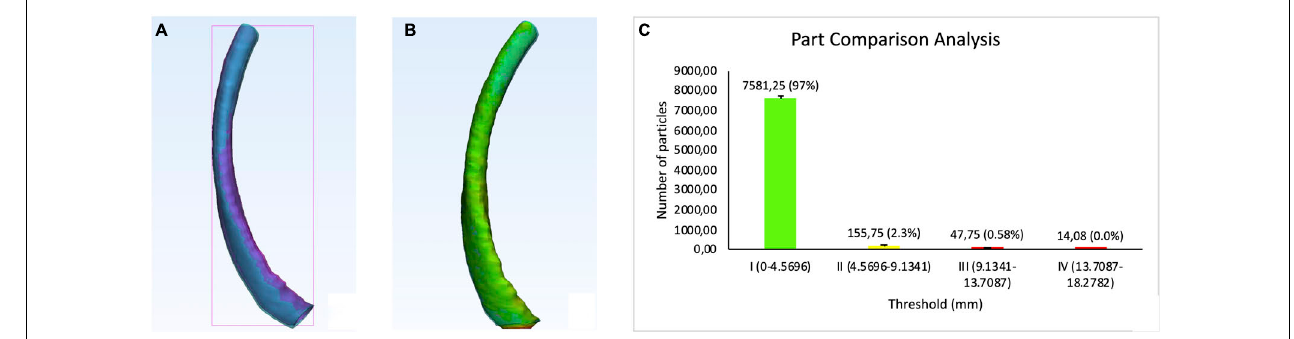
FIGURE 10 | Physical dimensional comparison of 3D printed rib specimens. (A) Registration of one of the twelve CT-derived STLs of the 3D printed rib specimens (purple) on the patient thorax CT-derived STL (pink) using anatomic landmarks in 3-Matic 13.0 software, (B) Color-coded result of Part comparison analysis, (C) Graph explaining the color-coding based quantification of element overlap; 97% elements on the patient rib overlap with the 3D printed ribs. TABLE 4 | Detailed description of the histogram of segmentation analysis of the PPCA between the STL files acquired from the patient and twelve phantom ribs CT.